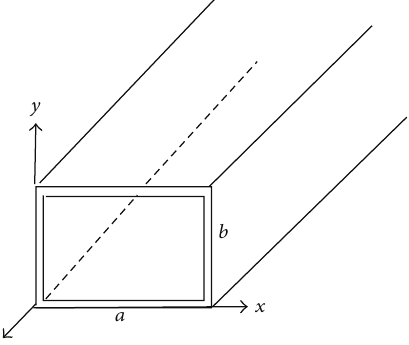
Figure 1: Rectangular waveguide. The electric and the magnetic ⃗𝐸 ⃗𝐵 fields and , respectively, are perpendicular to the wave vector ⃗𝑘 = (0,0, 𝑘 ) 𝑧